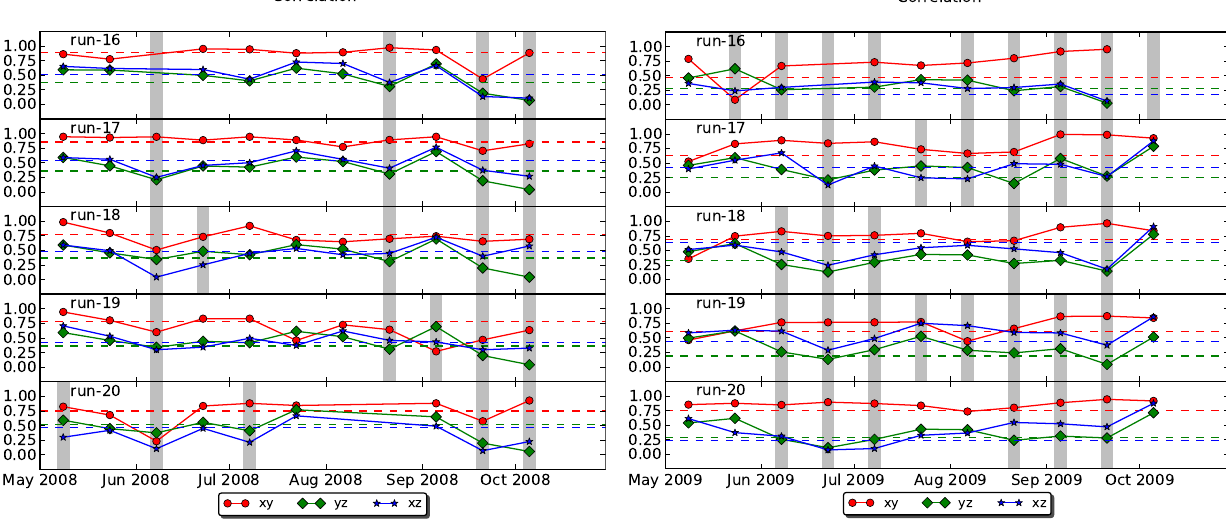
Fig. 5. Correlation coefficients for dynamic TC analysis with dT = 30 days for relationship between station and model (xy,red), model and satellite (yz,green) and station and satellite (xz,blue) for the years 2008 and 2009. Dates correspond to center of analyzed time period. Grey bars indicate cases where at least one of the correlations was not significant at the 95% level.